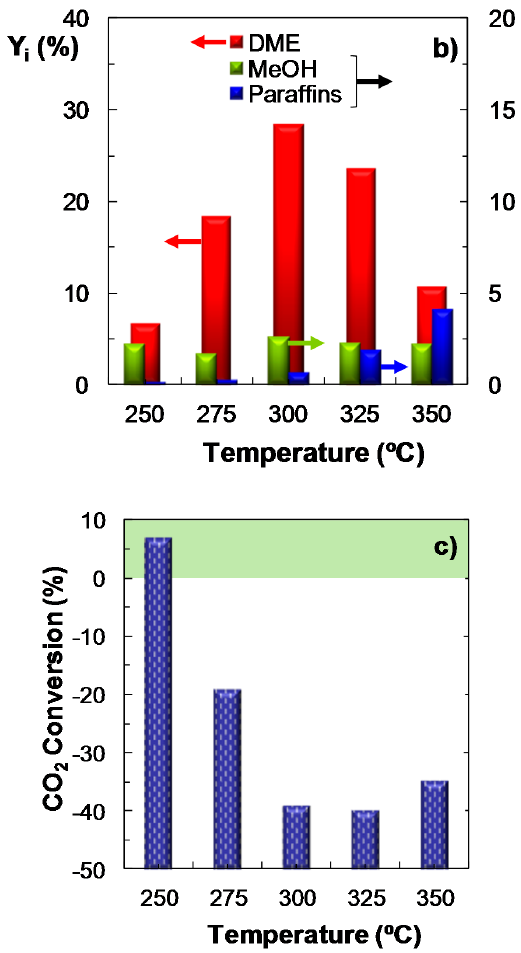
Figure 2. Effect of temperature on the conversion of CO x ; ( a ). Product yield; ( b ). CO 2 conversion (or CO 2 yield, for negative values); ( c ). Reaction conditions: Feed, H 2 + CO + CO 2 with H 2 /CO x molar ratio of 3, and CO 2 /CO molar ratio of 1/3; 30 bar; 10 g cat h (mol C ) − 1 .